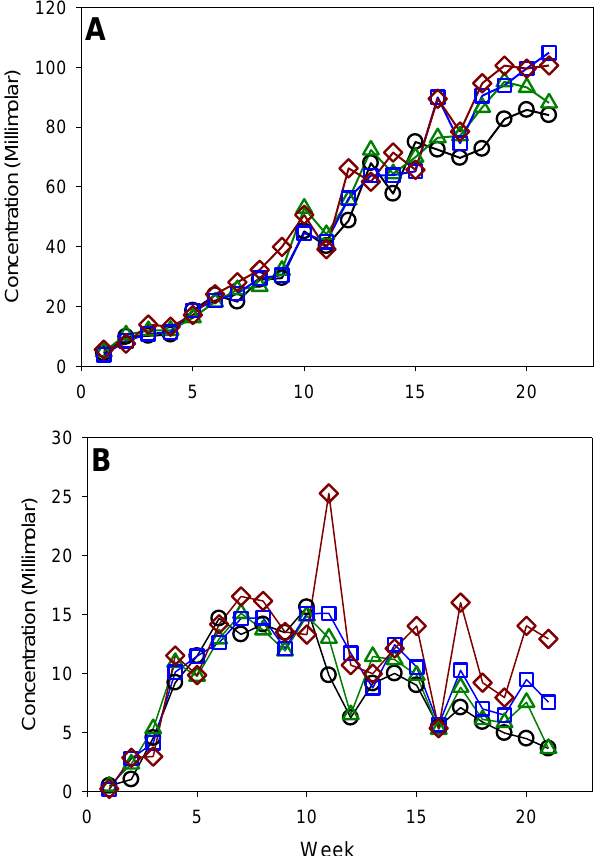
Figure 3. Bicarbonate ( A ) and soluble CO 2 ( B ) concentrations in digesters. Black line, circles: 0 mL supplemental aeration; green line, triangles: 200 mL aeration; blue lines, squares: 400 mL aeration; red lines, diamonds: 2000 mL aeration.